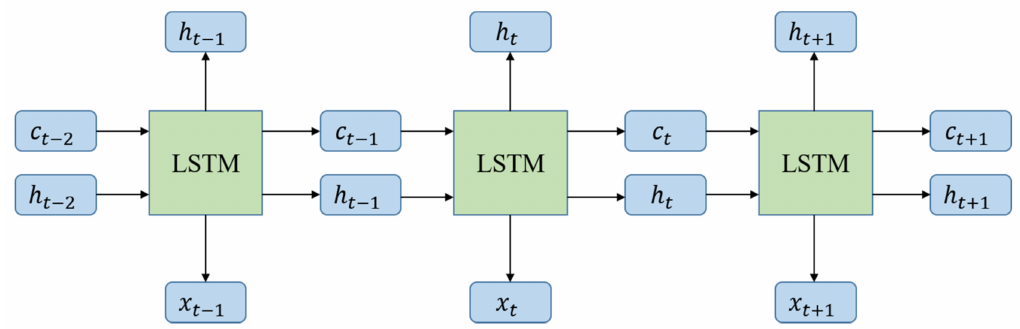
Figure 3. The training process of LSTM.